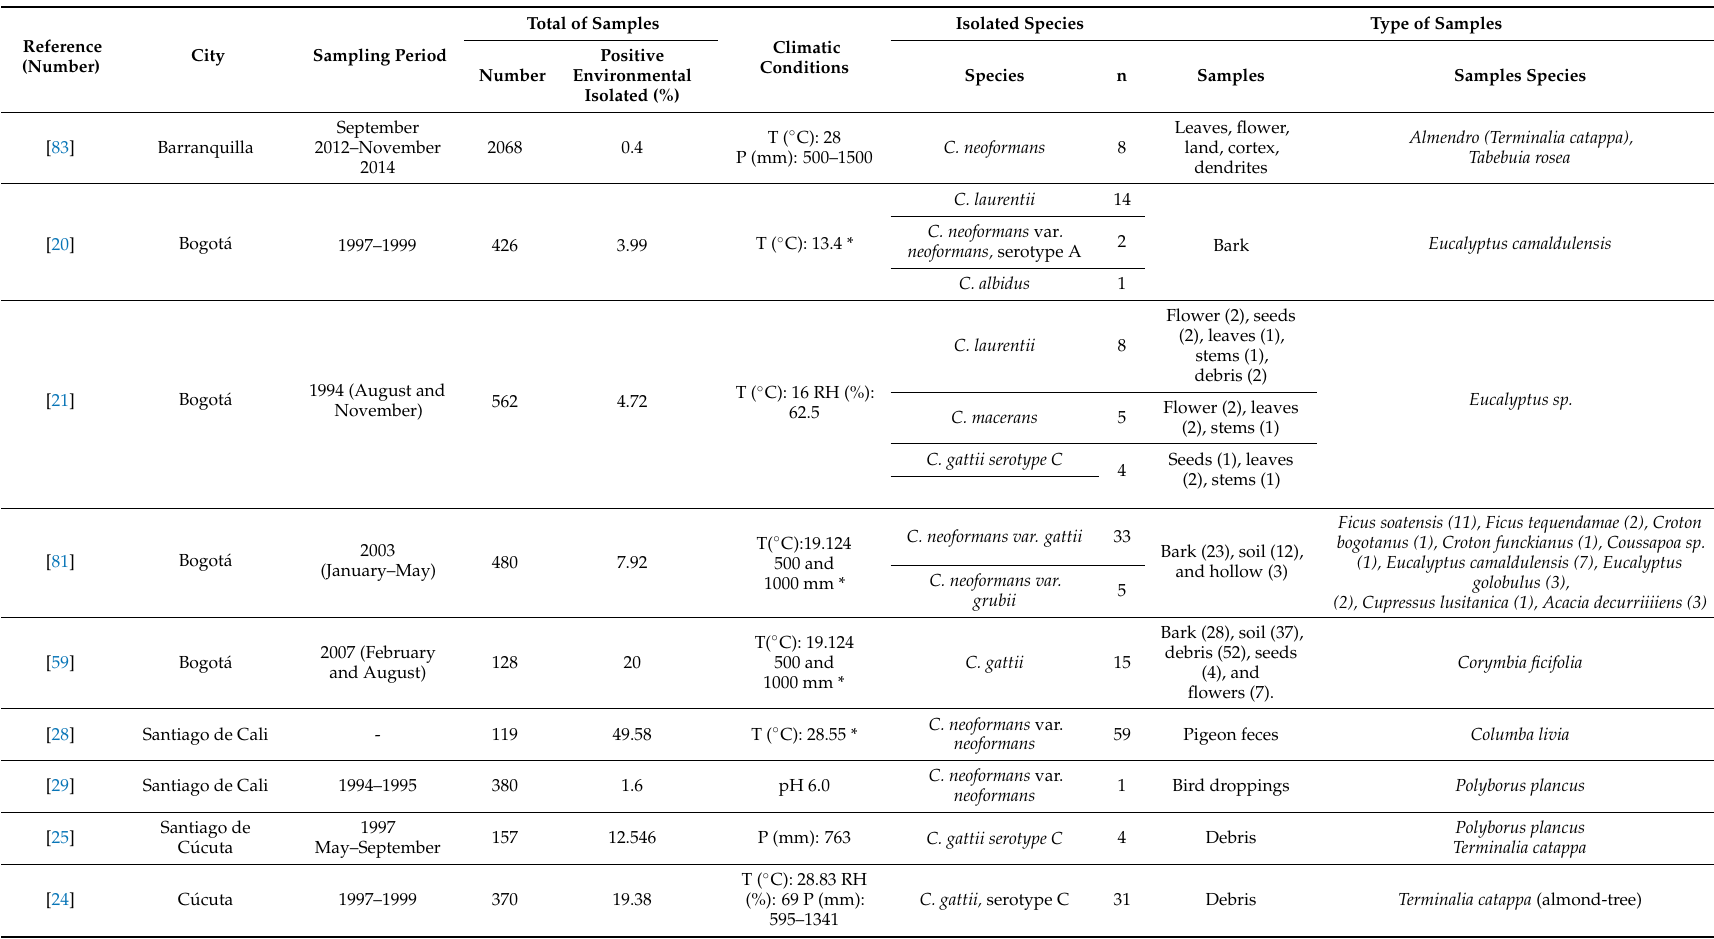
Table 1. Environmental isolates of the Cryptococcus genus registered in